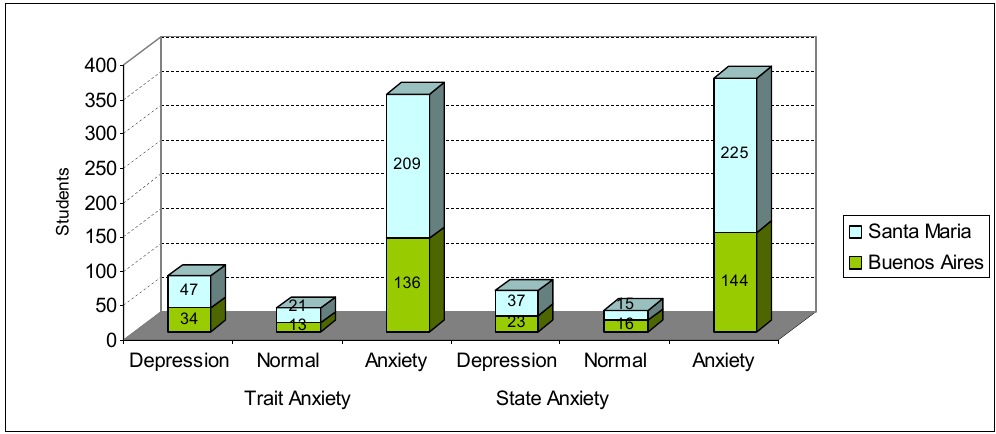
Figure 6. State and trait anxiety inventory of students from Buenos Aires and Santa Maria. Source: survey data.